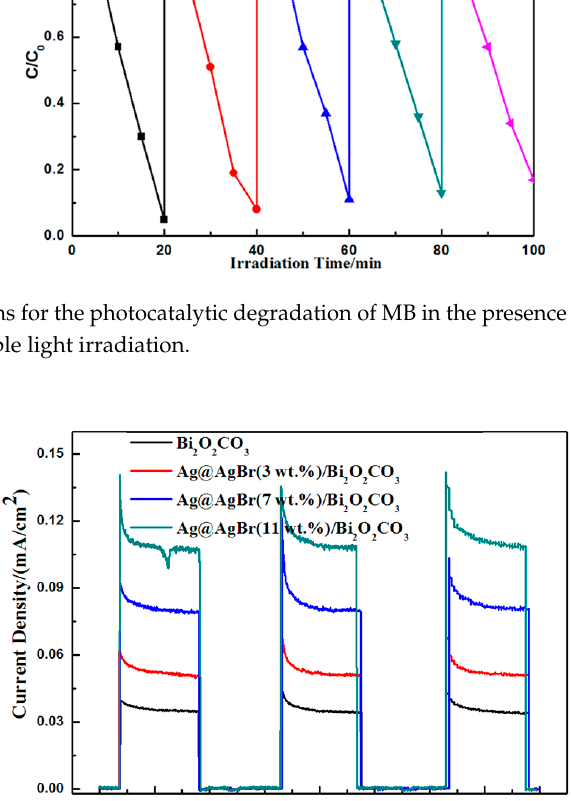
Figure 11. Current density-time curves of electrodes made from pure Bi 2 O 2 CO 3 , and photocatalysts of various Ag@AgBr contents.